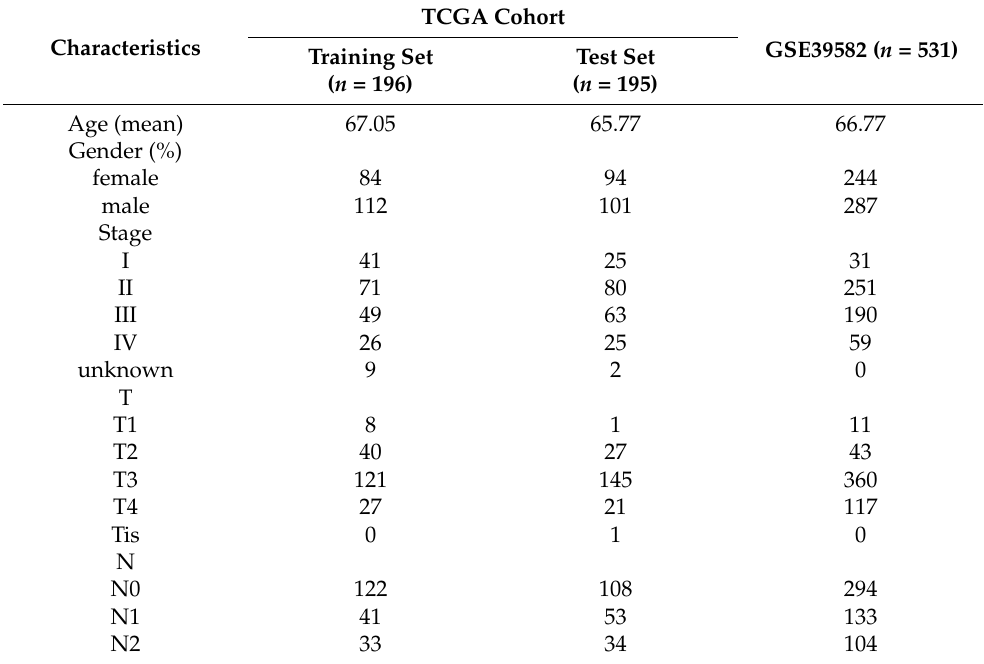
Table 1. Clinical characteristics of patients with colon